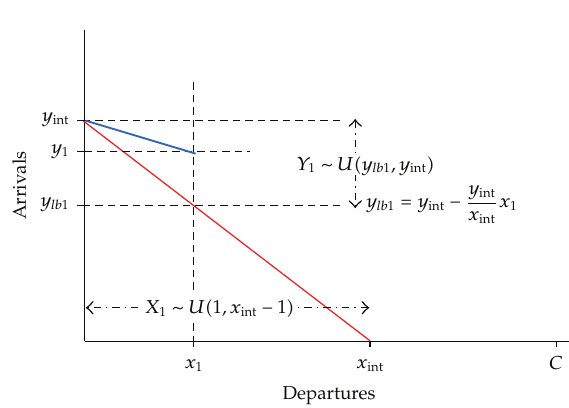
Figure 9: Step 2: the first pivot location (cid:2) x 1 ,y 1 (cid:3) is